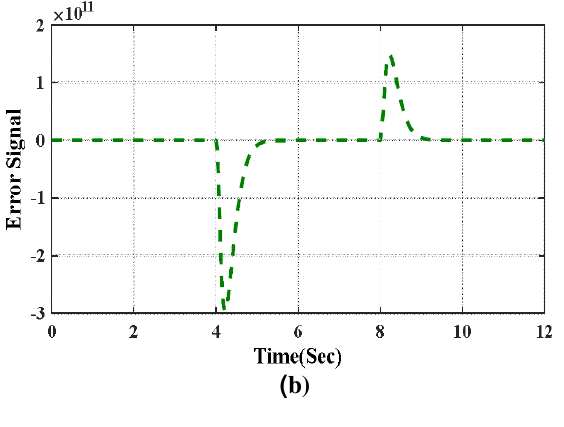
Fig. 14. Simulation results for robotic leg controlled with PD+NID and multi-step input of mag.2: (a) angular position, error signal .